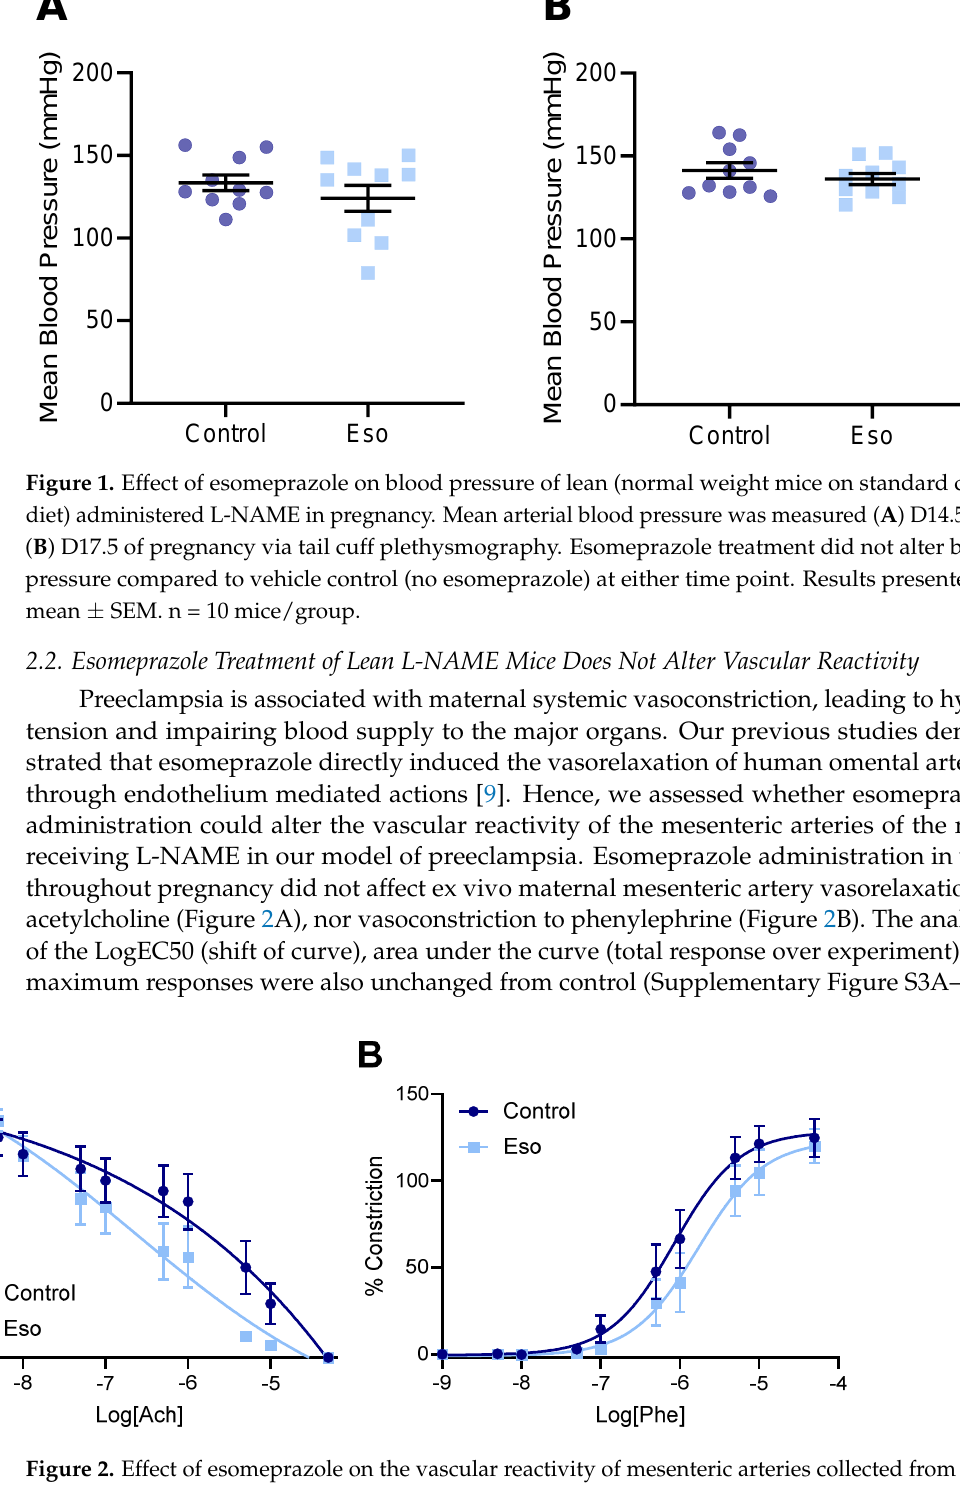
Figure 2. Effect of esomeprazole on the vascular reactivity of mesenteric arteries collected from mice receiving L-NAME through pregnancy. Wire myography was used to assess ( A ) vasorelaxation to acetylcholine (Ach) and ( B ) vasoconstriction to phenylephrine (Phe). Treatment with esomeprazole alongside L-NAME administration in pregnancy did not significantly alter the vascular response to acetylcholine or phenylephrine at any dose assessed. Data points are presented as mean ± SEM, and non-linear regression performed (log(agonist) vs. response–variable slope (four parameters)). n = arteries from 6–8 mice/group.